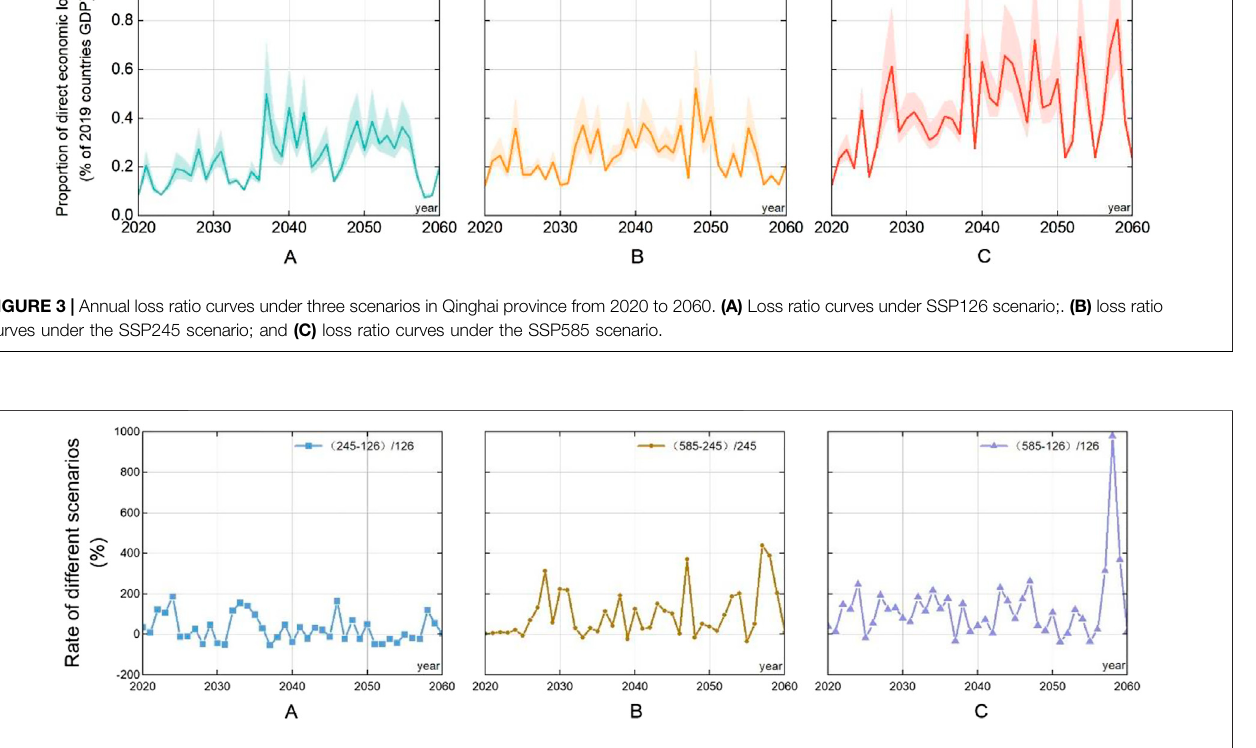
FIGURE 4 | Comparison chart of loss ratios under three scenarios in Qinghai province from 2020 to 2060. (A) Change range of the fl ood disaster loss ratio under SSP245scenariowithmediumcarbonemissioncomparedwithSSP126scenariowithlow-carbonemission; (B) changerangeofthe fl ooddisasterlossratioofSSP585 scenario with high-carbon emission compared with SSP245 scenario with medium carbon emission; (C) change range of the fl ood disaster loss ratio under SSP585 scenario with high-carbon emissions compared with SSP126 scenario with low-carbon emission.